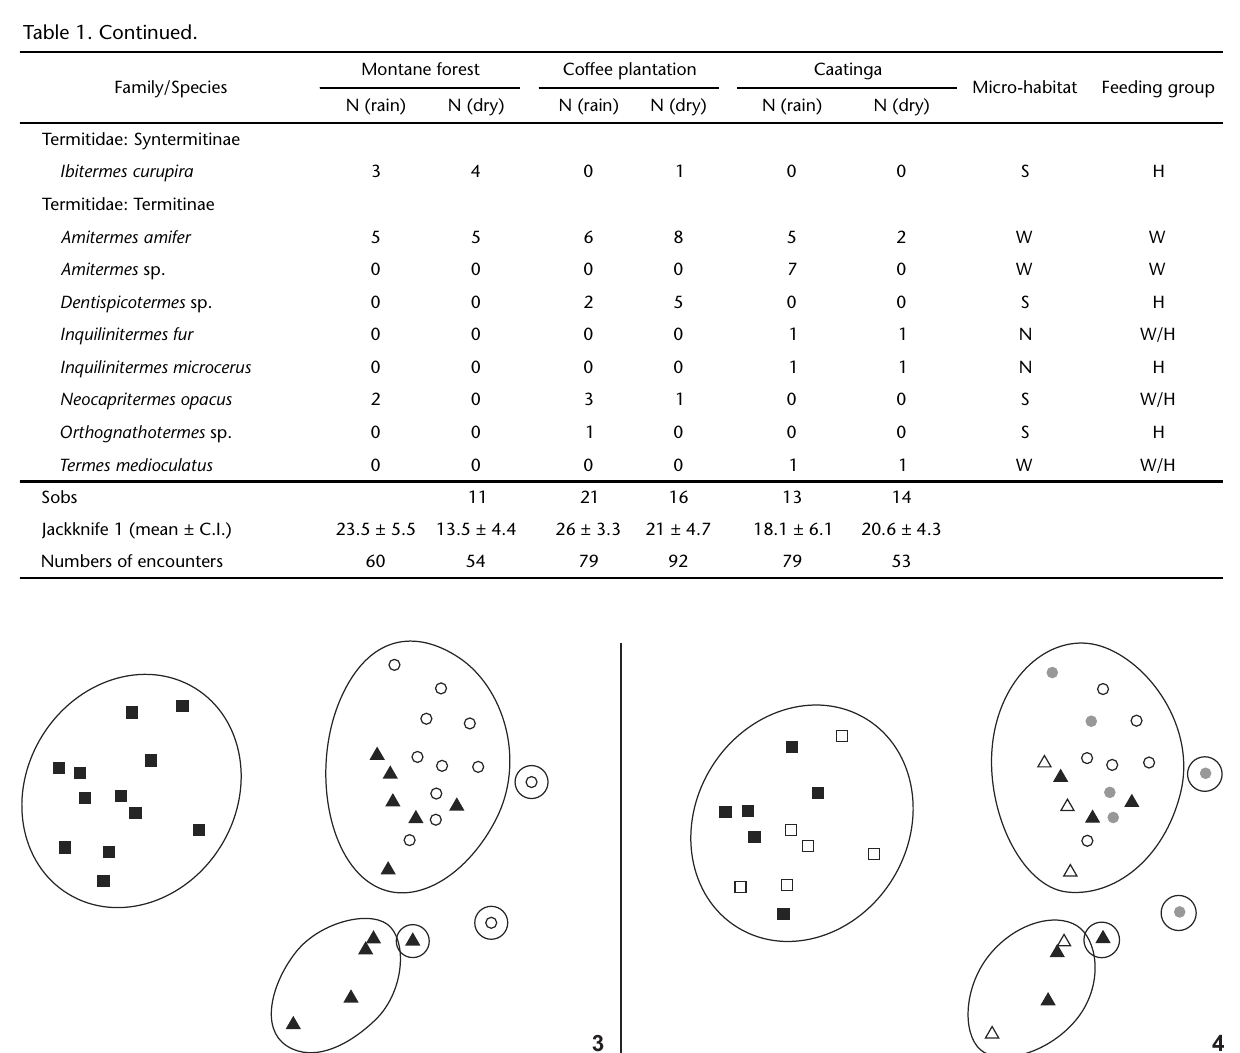
Figures 3-4. Non-metric multidimensional scaling of the termite fauna of three phytophysiognomies in the Agreste region of the state of Pernambuco, northeastern Brazil. Groups formed using a 40% level of similarity. (3) Ordination performed considering only